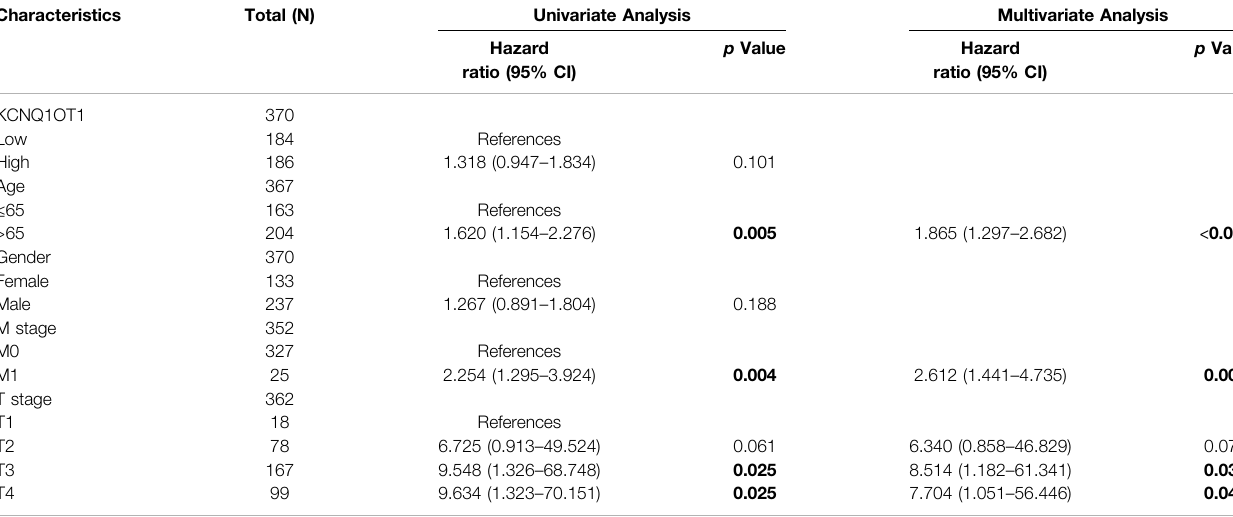
TABLE 2 | Univariate and multivariate Cox analysis of clinical variables and KCNQ1OT1. Characteristics